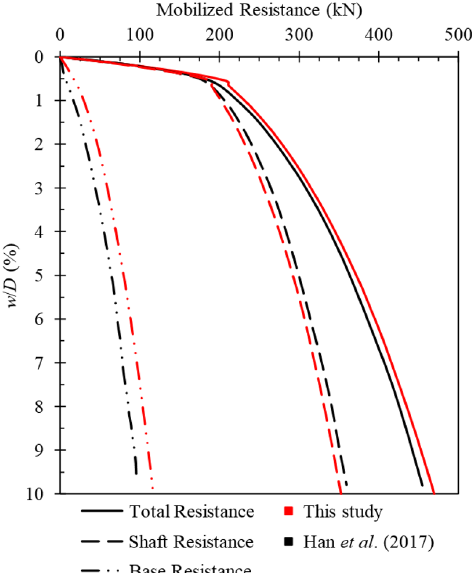
Figure 8. Results for the mobilized resistance as a function of the relative settlement of the pile head.